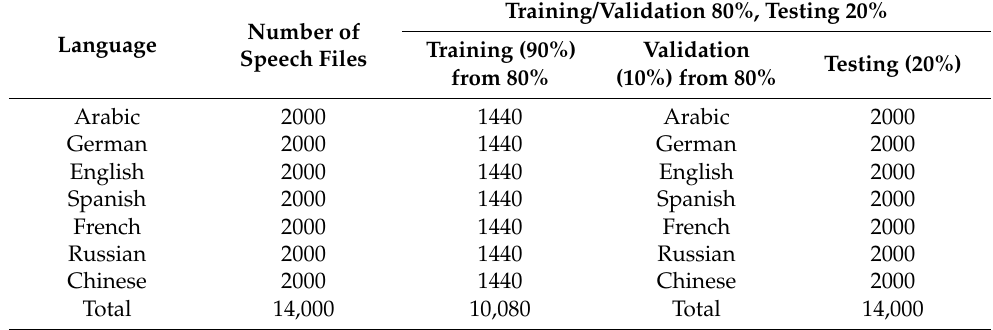
Table 3. Selected Mozilla corpus description.